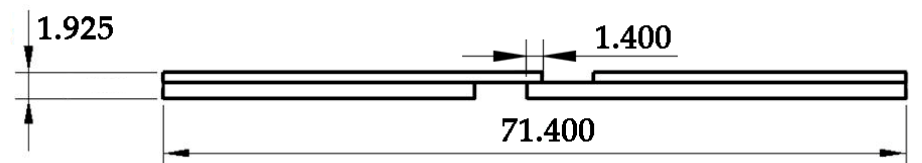
Figure 2. Schematic diagram of shearing sample (units: mm).